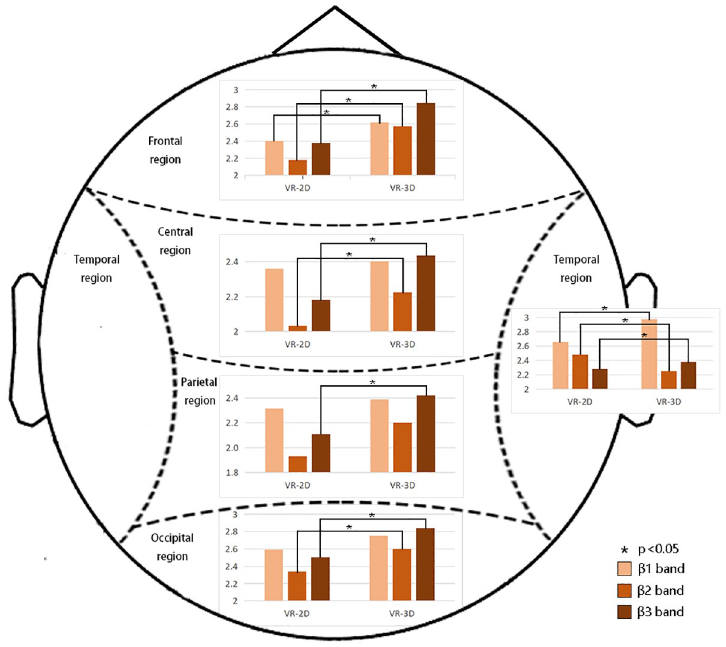
Fig 10. Significant differences in different brain regions under VR-2D or VR-3D modes for the β 1, β 2 and β 3 wave bands. The results demonstrated that VR-3D elicited greater beta activity than VR-2D.